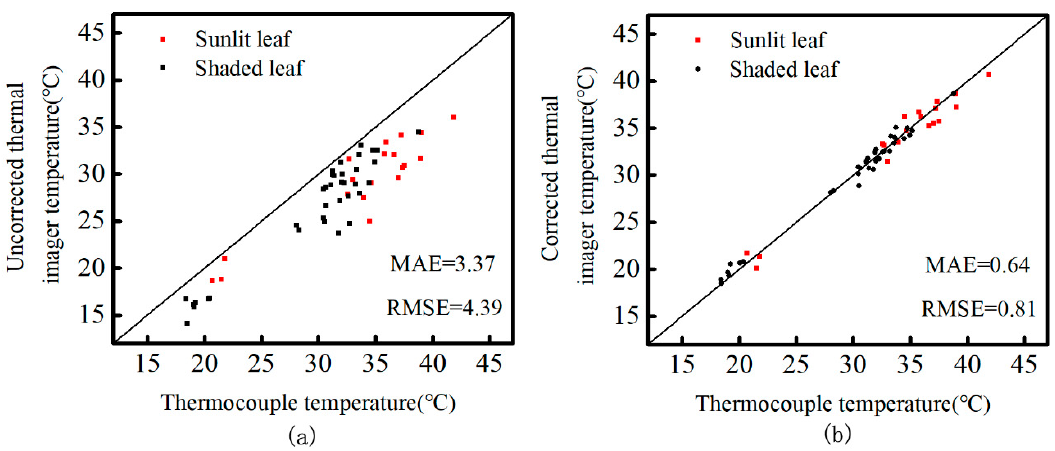
Figure 10. ( a ) Comparison of uncorrected canopy temperature measured by thermal imager and thermocouple; ( b ) Comparison of corrected canopy temperature measured by thermal imager and thermocouple. Table 2. Accuracy of the thermal imaging camera in extracting the sunlit and shaded canopy temperature. Sunny / Shady